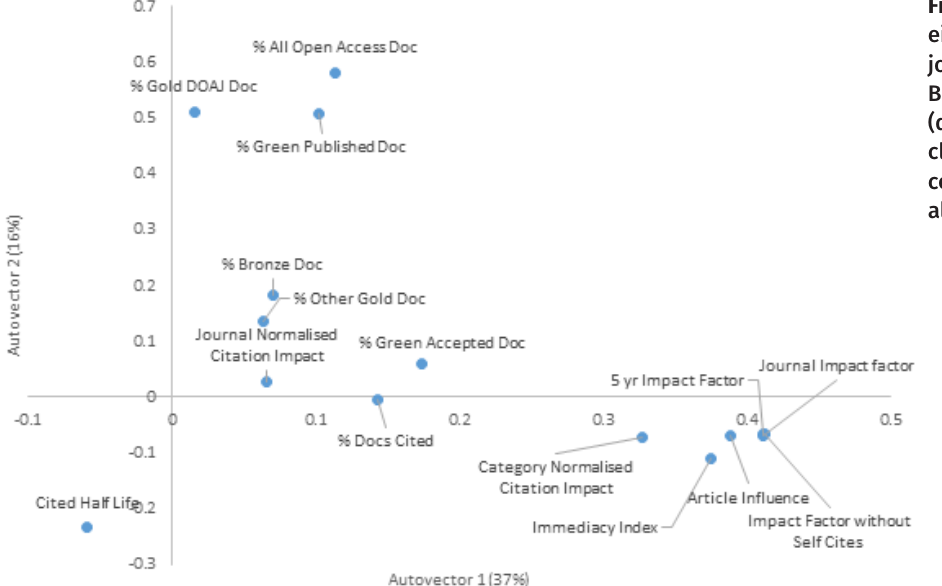
Figure 8. First two eigenvectors for journal traits